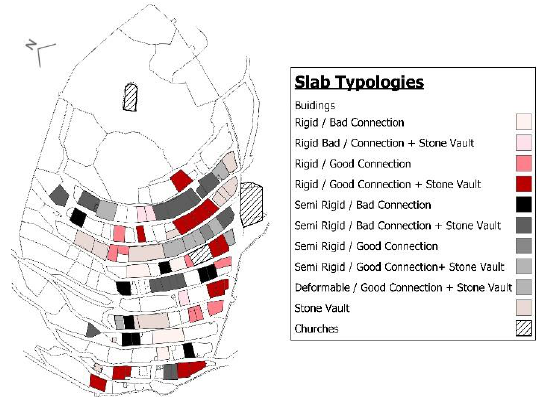
Table 1. Damages distribution in Campi Alto di